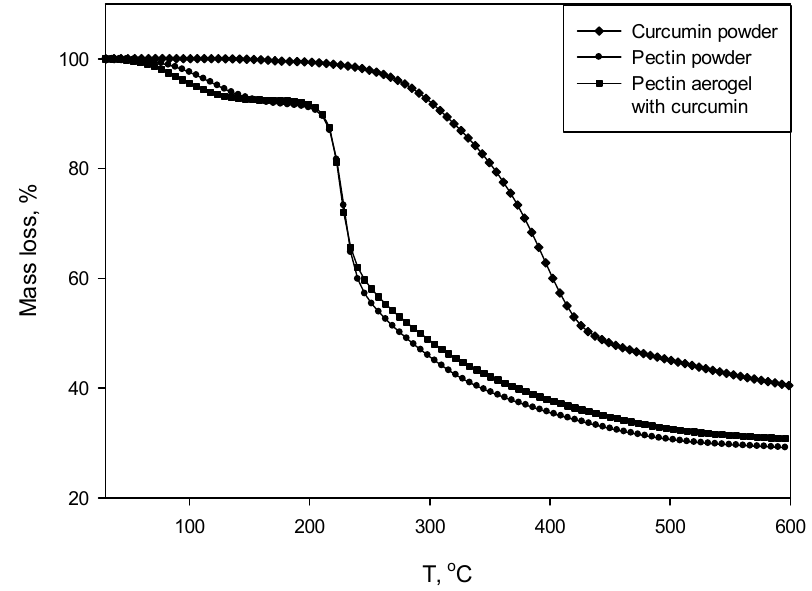
Figure 6. Thermogravimetry (TGA) curves for curcumin powder, pectin powder, and pectin aerogel loaded with